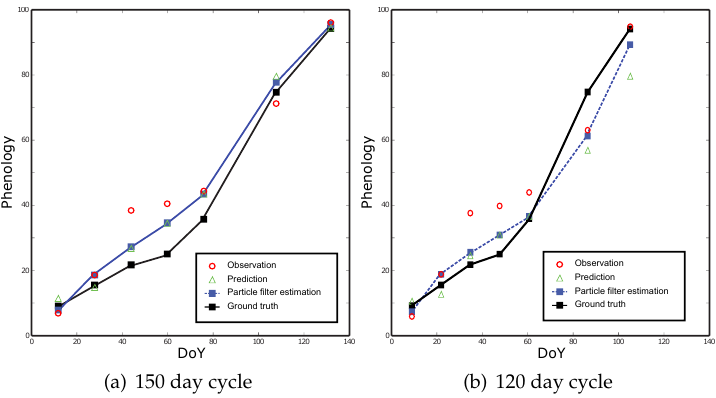
Figure 8. Example of state estimations for a parcel with normal ( a ) and faster ( b ) development. The black solid line shows the ground truth measurements. Green triangles show the most likely value given by the model at instant k + 1 (i.e., prediction). The red circles show the more likely value given by p ( y k + 1 | x k + 1 ) at instant k + 1 (i.e., observation). The blue dashed line is the combination of both provided by the particle filter (i.e., estimation).